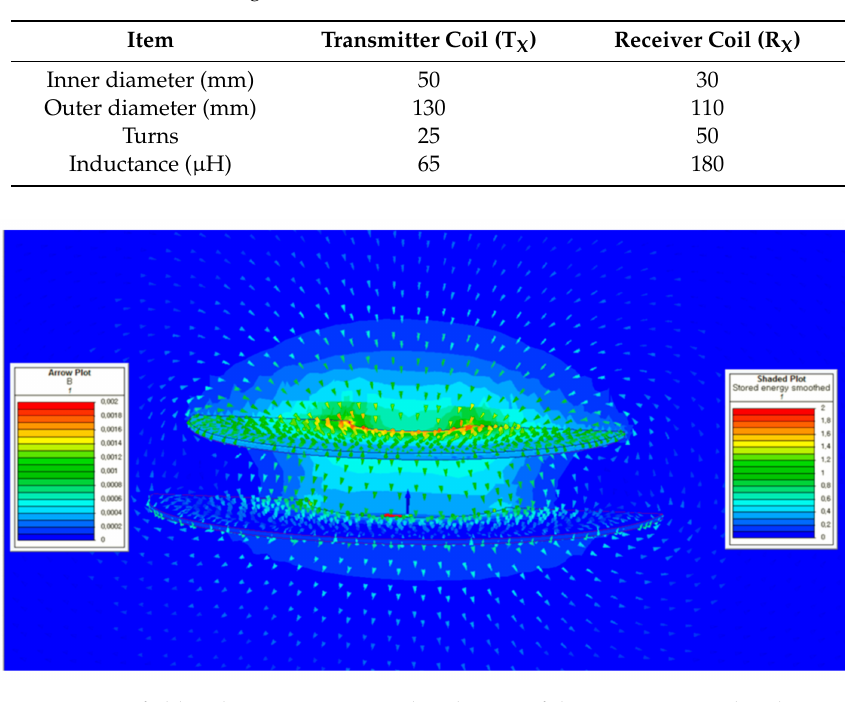
Figure 6. Magnetic field and magnetic energy distribution of the transmitter coil and receiver